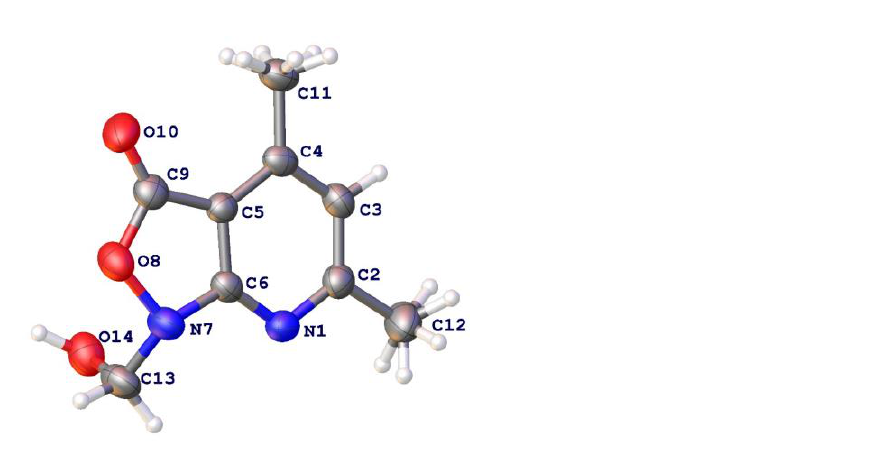
Figure 1. Molecular structure of 2 . Displacement ellipsoids are shown at the 50% probability level.